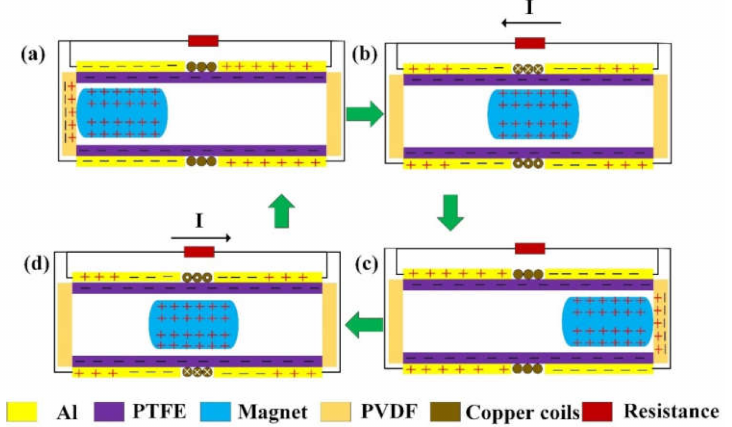
Figure 2. Schematic diagrams showing the operation mechanism and the corresponding current flow from the three generator units, i.e., EMG, PEG, and TENG. ( a ) The magnet on the left end and impacting the left PVDF film. ( b ) The magnet moving from left to right. ( c ) The magnet on the right end and impacting the right PVDF film. ( d ) The magnet moving from right to left.